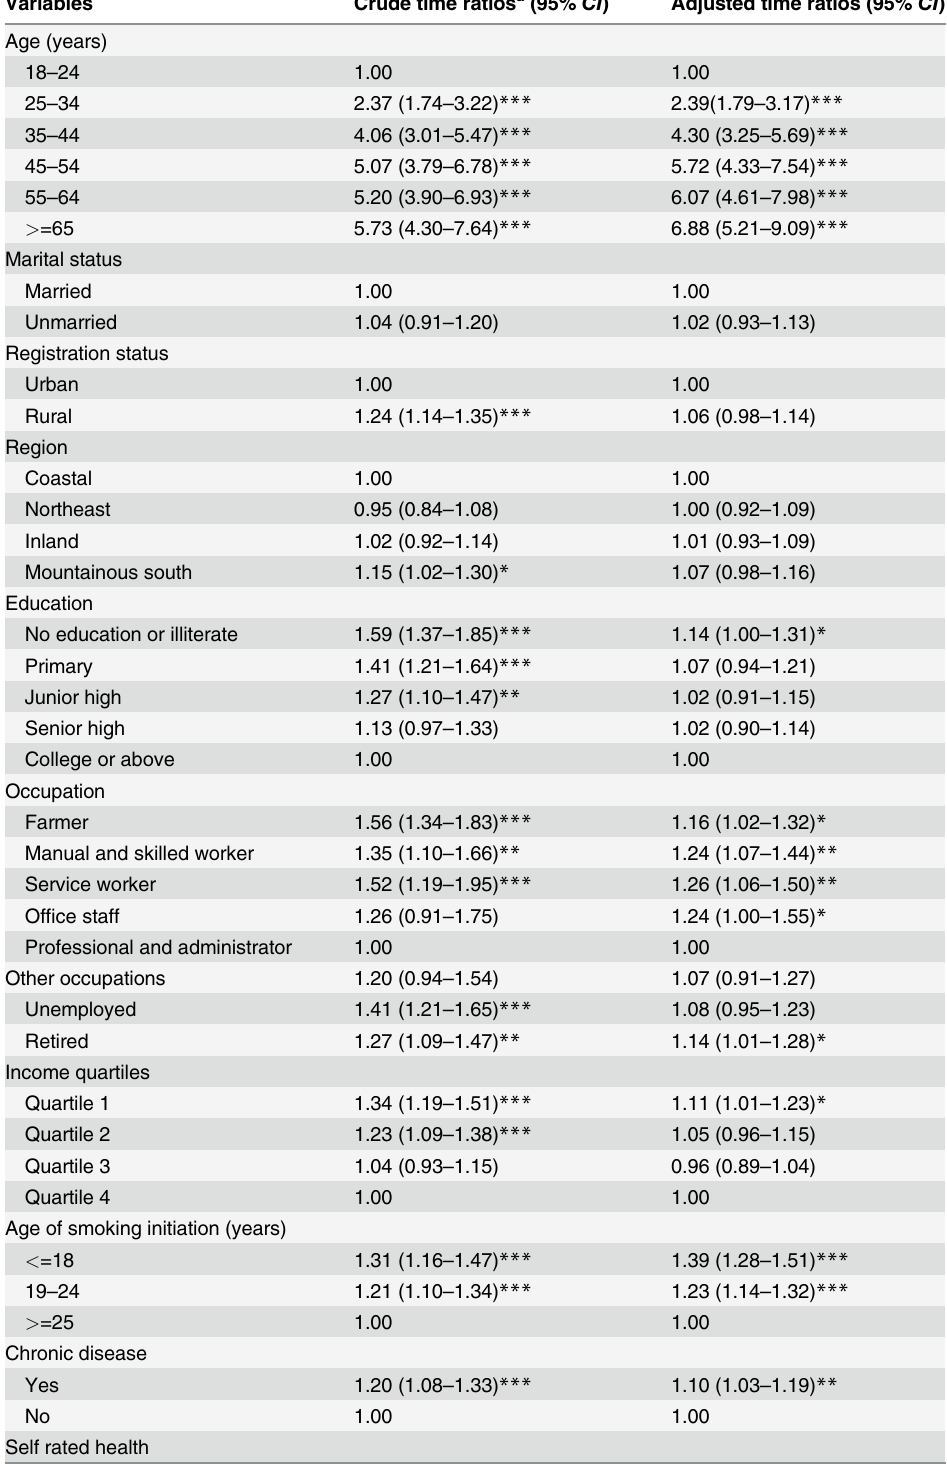
Table 2. Log-logistic Regression Models Estimating the Association between SES and Duration of Smoking among Male Ever Smokers Aged 18+, CHNS, 2006 (N =